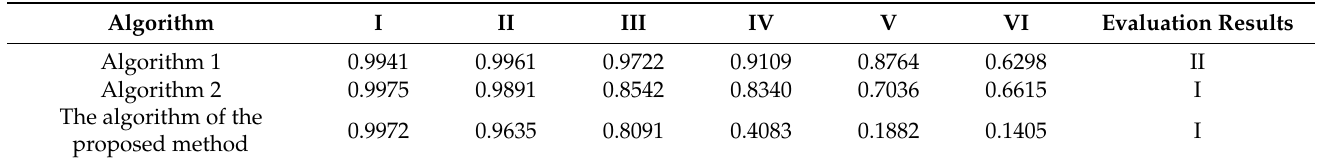
Table 10. Evaluation results of different algorithms in the husking stage.